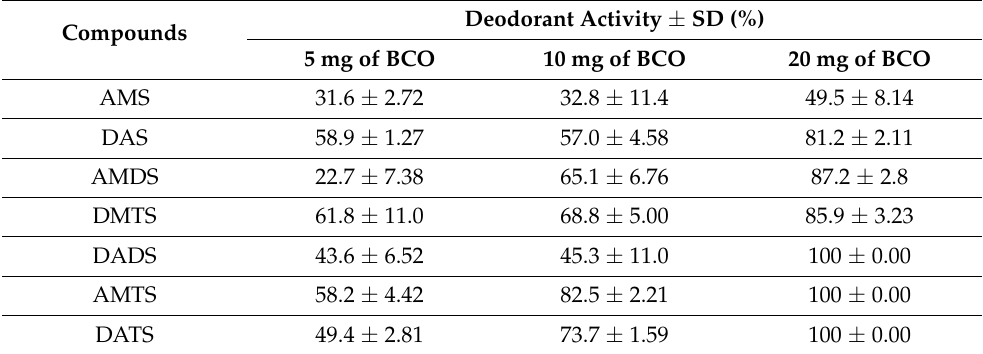
Table 2. Deodorant activity of each dosage of black cumin seed oil (BCO) against sulfur compounds at pH 1.2 assay buffer.